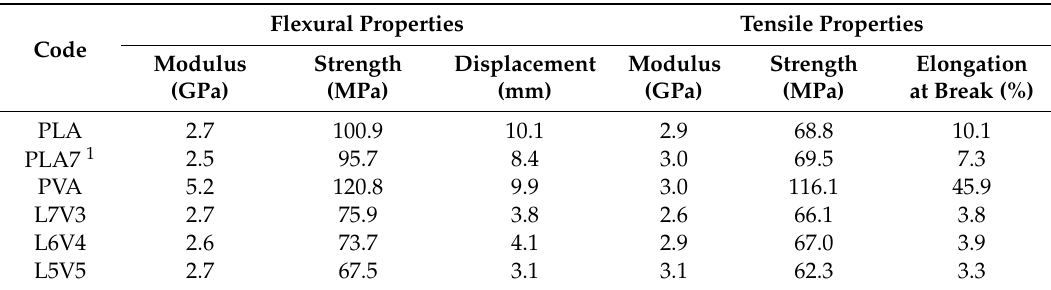
Table 3. Mechanical properties of injected PLA, PVA, and their blends.